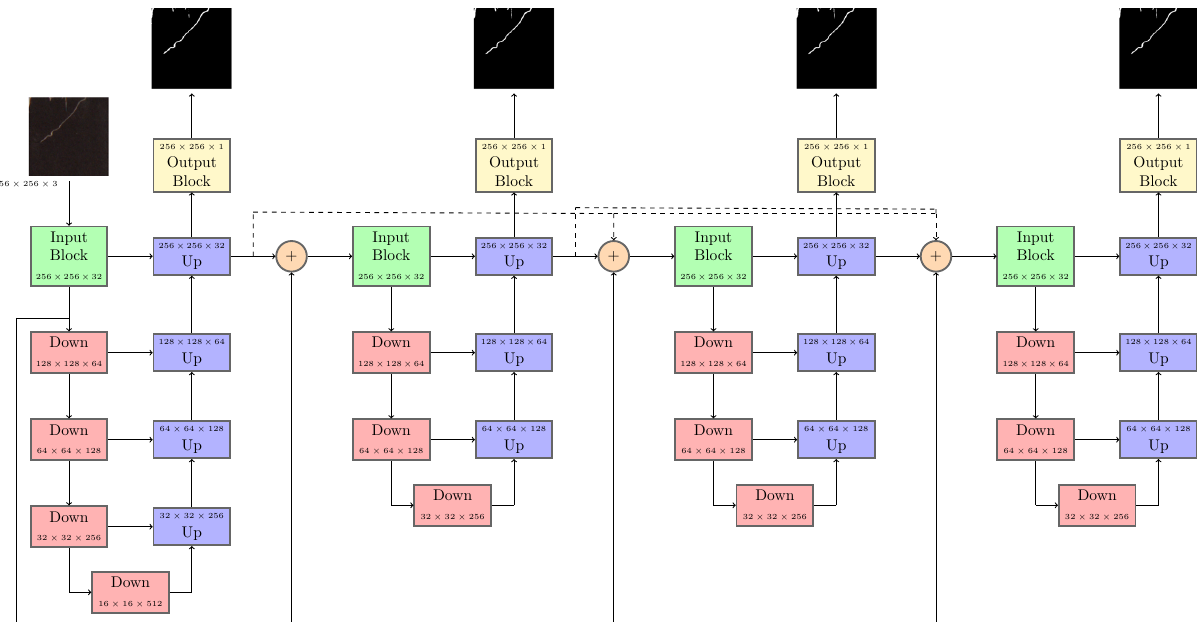
Figure 2. Network architecture diagram showing a high level view of the blocks making up the network. One main U-Net structure acts as input to the subsequent smaller U-Net structure. High- level image features are concatenated to the inputs of all networks via skip connections (solid line), and learned high-level features at the output of each iteration are concatenated together with the inputs of each subsequent iteration (dotted lines). Each network iteration has its own segmentation output, and the last network’s output is considered to be the final